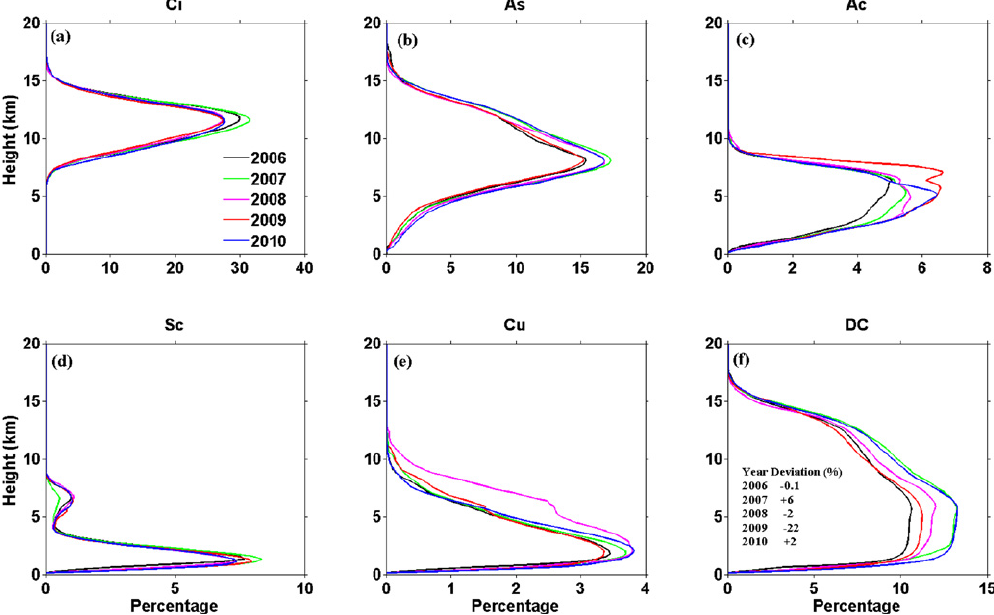
Fig. 4. Vertical distribution of frequency of occurrence of (a) Ci, (b) As, (c) Ac, (d) St, (e) Cu and (f) DC clouds averaged over the ISM region during